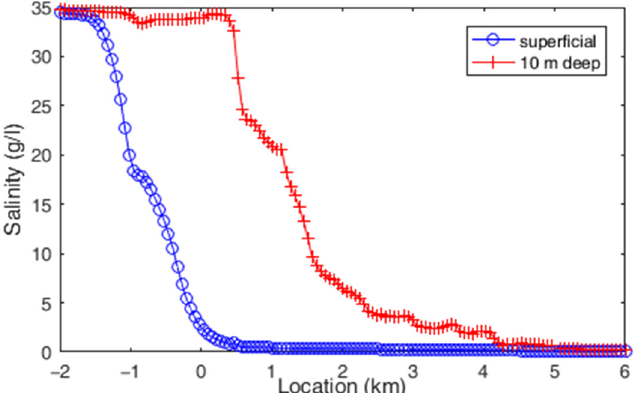
Figure 3. Salinity profile estimated by the hydrodynamic model for the final stretch of the Magdalena river. The horizontal axis indicates distance in km from the end of the river’s channel, with positive distances upstream of the river and negative distances seaward.